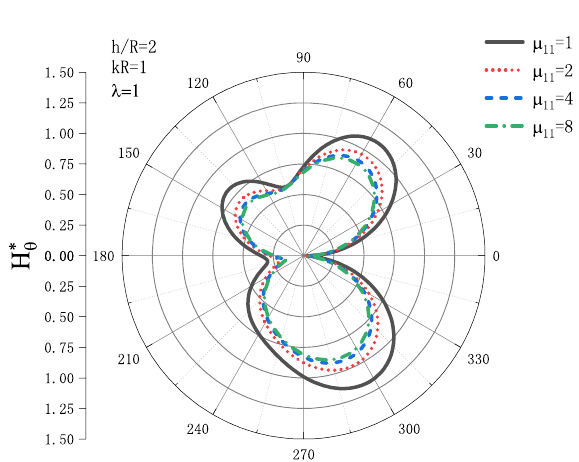
* µ 11 when incident frequency kR = 1 θ vs. the ratio of